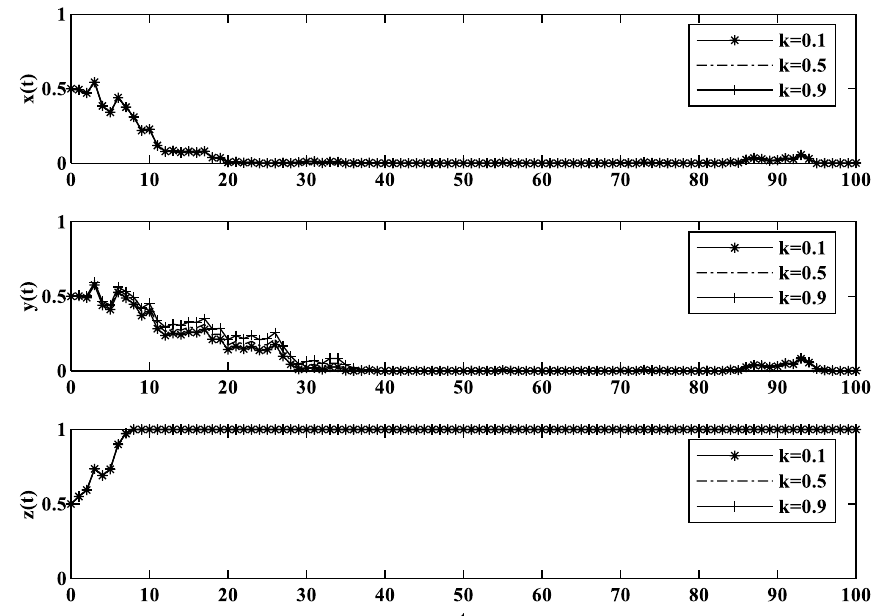
Fig. 7 Impact of culling rate on evolutionary process under scenario